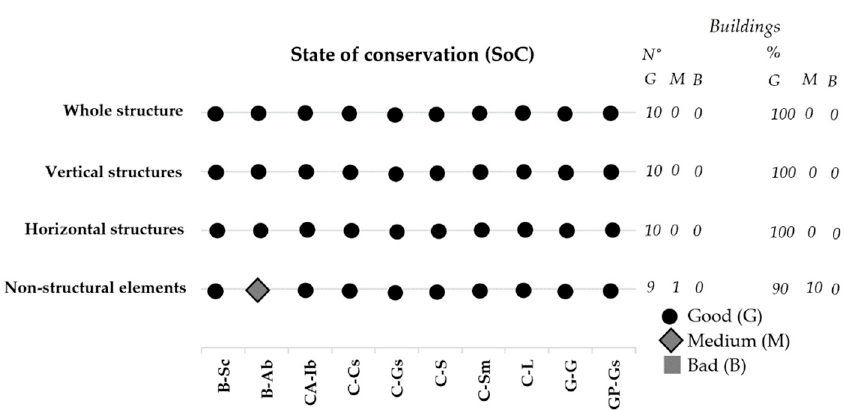
Figure 28. Section 3 CARTIS-Building. Other information: State of Conservation (SoC).